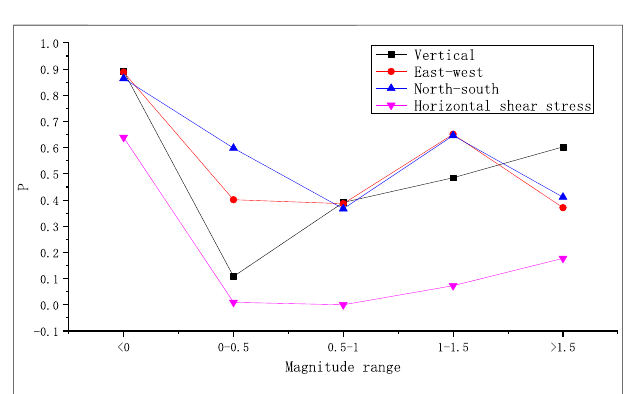
FIGURE 9 | p -values of different tidal stress components at different magnitude levels.